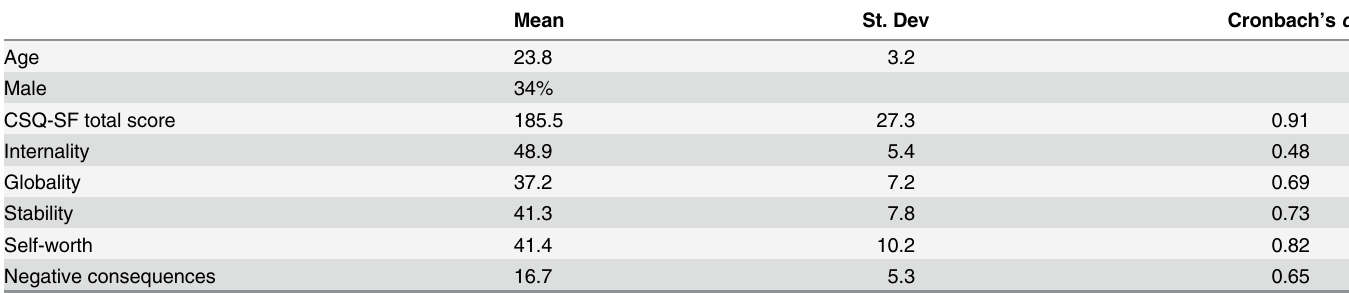
Table 1. Sample characteristics.